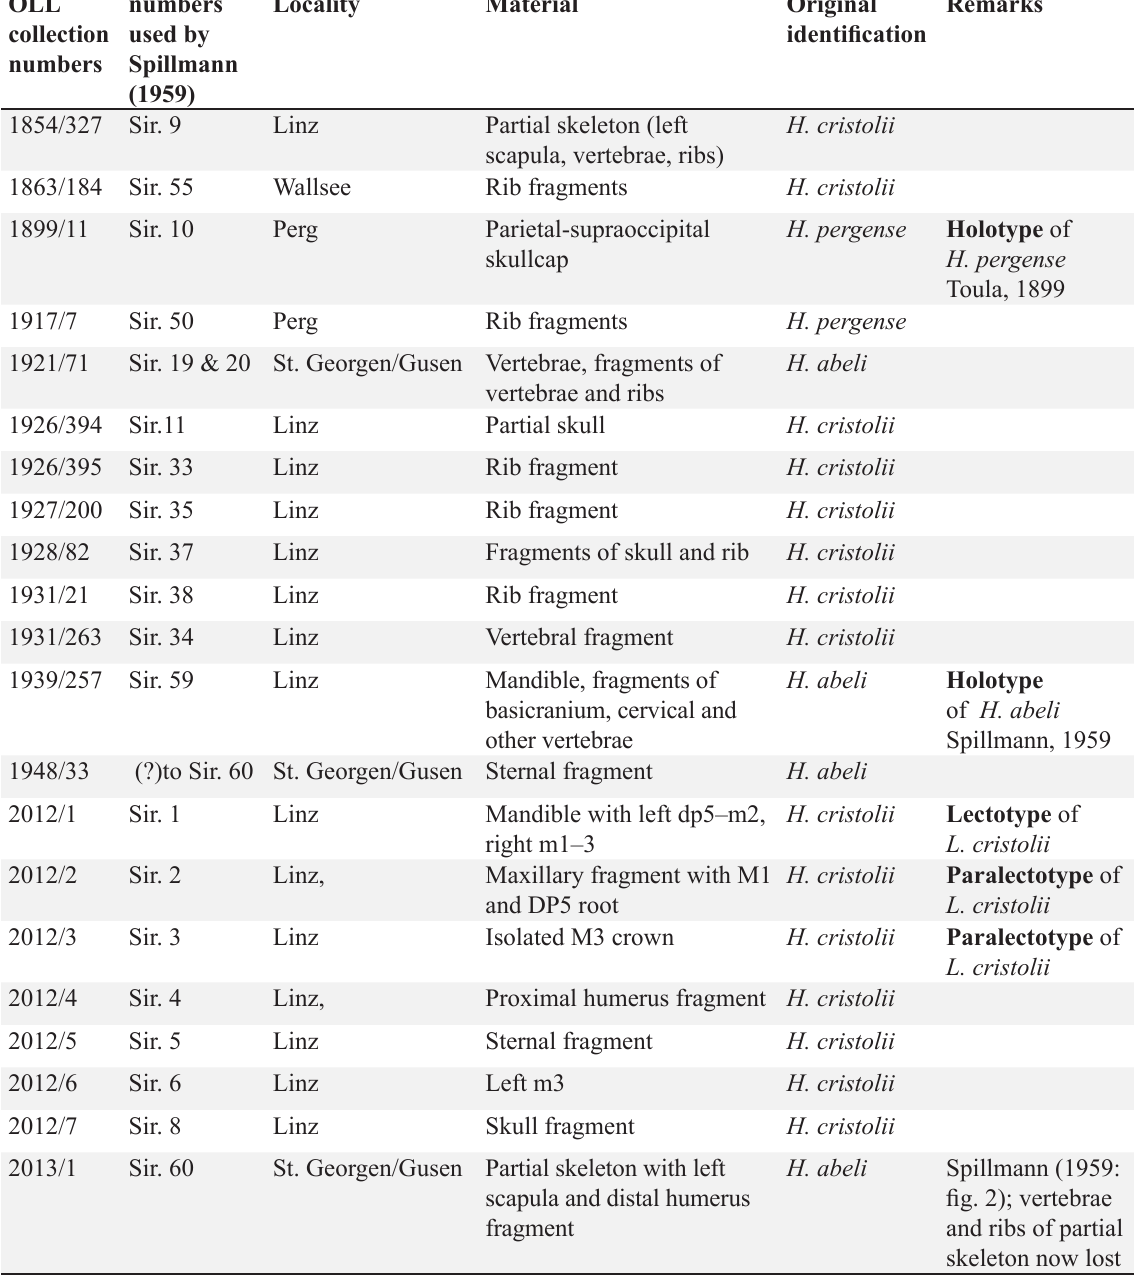
Referred material